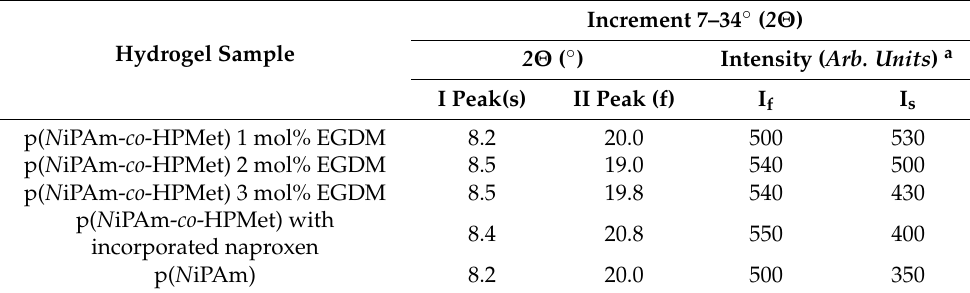
Table 4. The Values of Diffraction Angles and the Diffraction Peaks Intensities for the Co-Hydrogel Samples before and after Naproxen